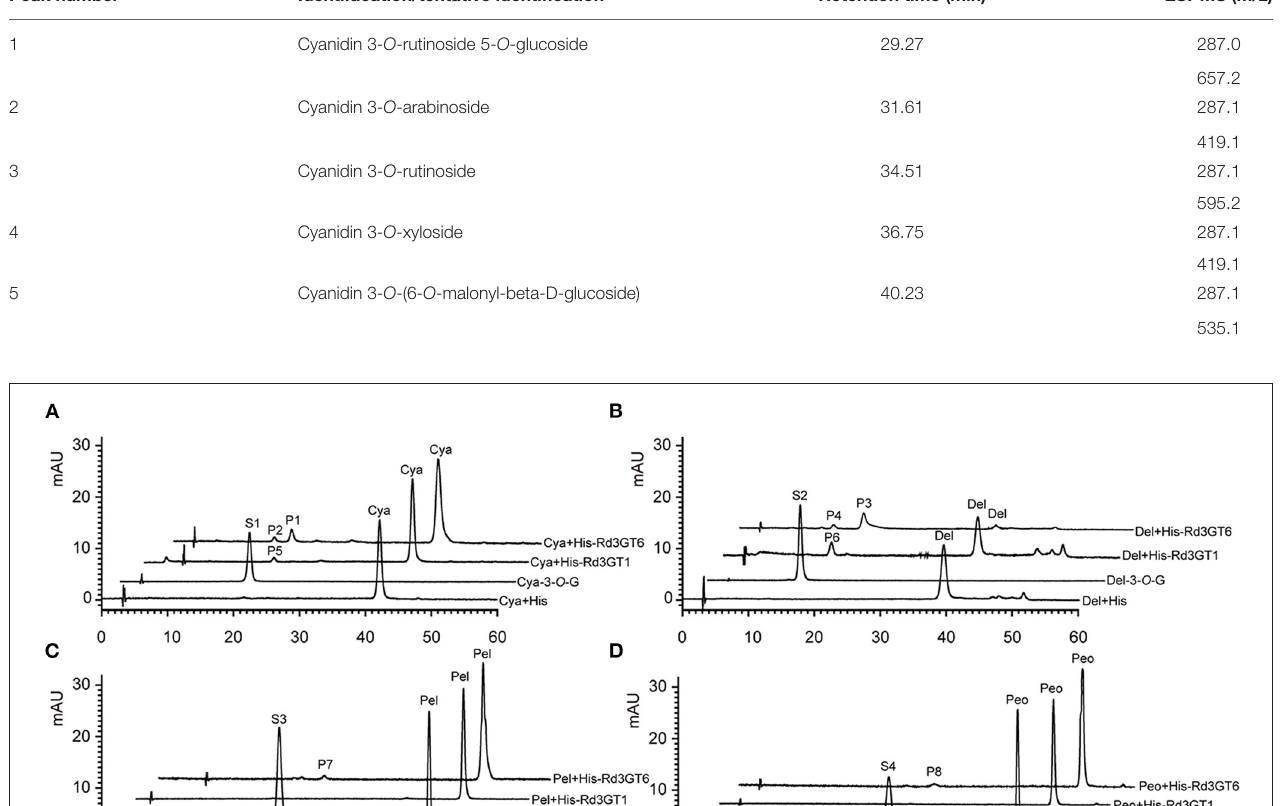
TABLE 2 | HPLC-ESI-MS analysis of anthocyanin extracts of Rd3GTs over-expressing transgenic tobacco flowers. Peak number